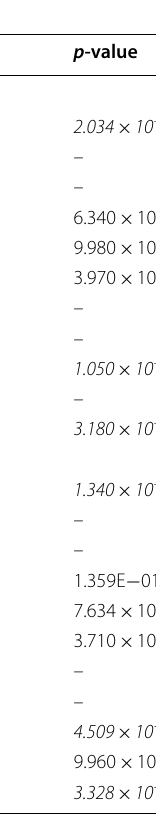
Italic values indicate p value <